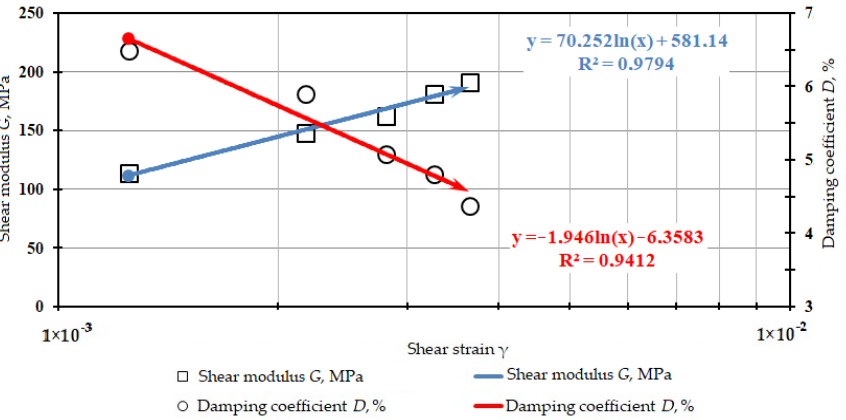
Figure A4. Graph of dependencies of generic shear modulus G/G 0 (unit fractions) and damping coefficient D (%) on the amplitude of shear strains γ (unit fractions) for cement stabilized soils. Test 4 (triaxial dynamic compression).